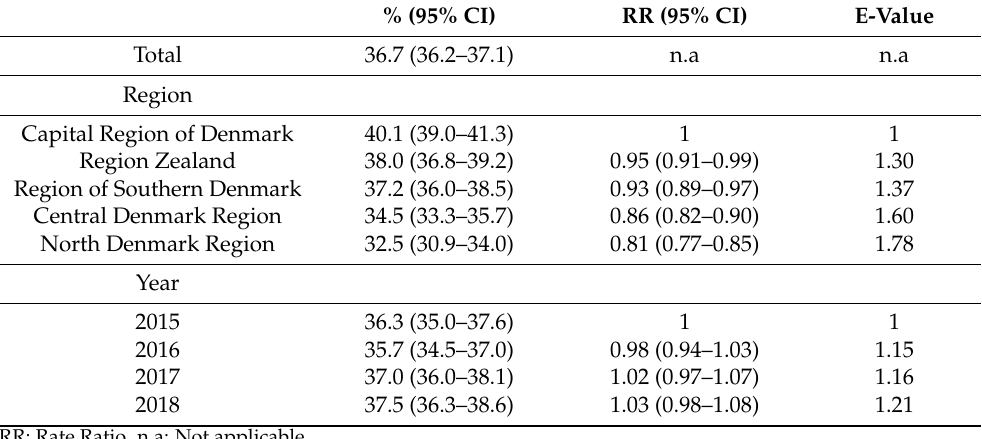
Table 2. Proportion of patients with three months to end-of-life, in total and by region and year.